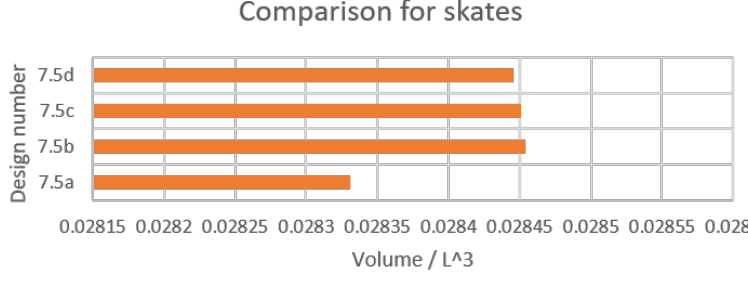
Figure 11. Value of non-dimensional volume for designs with skate